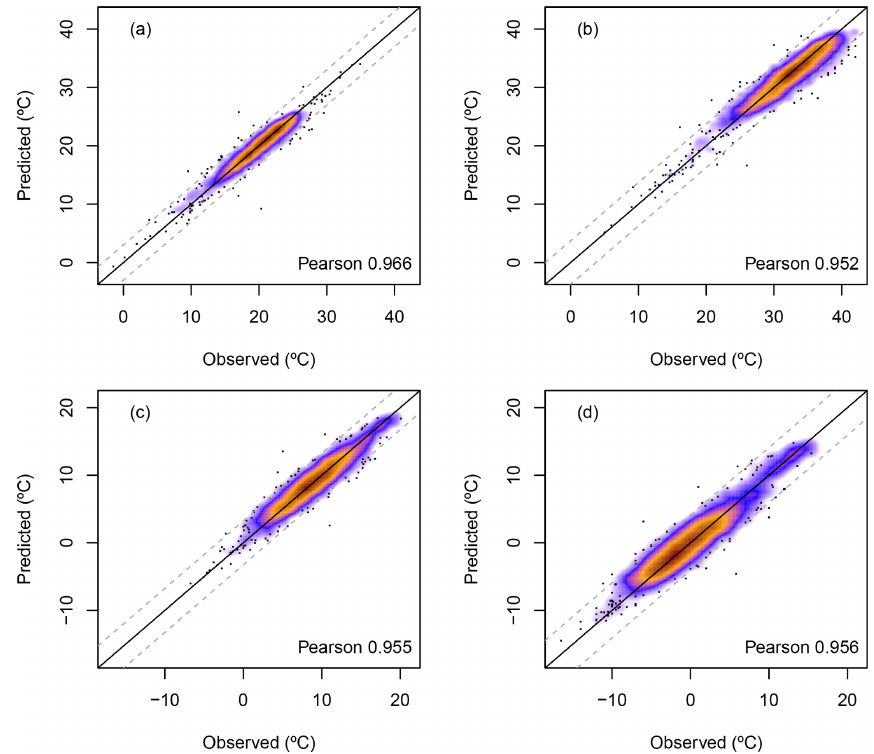
Figure 7. Comparison between observations and estimates, by stations ( n = 5520), of the mean maximum temperatures (a) and their 95th percentiles (b) , and comparison of the mean minimum temperatures (c) and their 5th percentiles (d) . Dashed lines represent ± 1 standard deviation of the data. Table 2. The leave-one-out cross-validation (LOO-CV) statistics showing the goodness of fit between maximum and minimum temperature observations and estimates of monthly aggregates. MAE: mean absolute error ( ◦ C); ME: mean error ( ◦ C); RM: ratio of means; RSD: ratio of standard deviations; Pearson: Pearson correlation coefficient. Results were constrained to two decimal